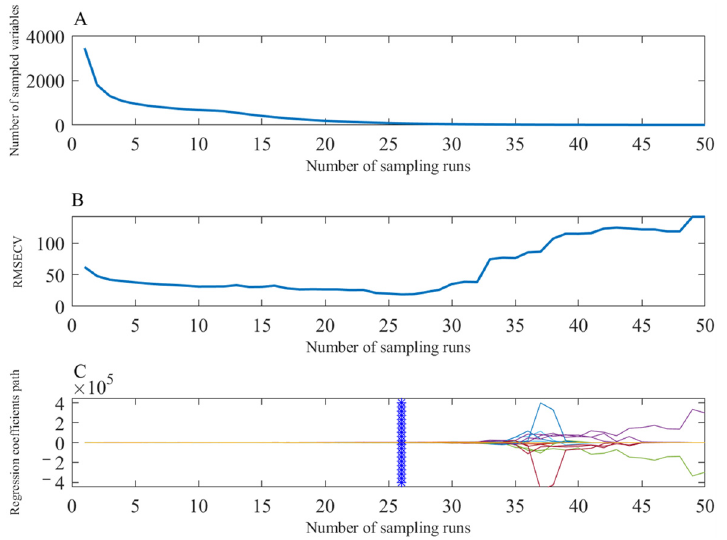
Figure 4. Results of the CARS method with the increasing of sampling runs. ( A ) the number of sampled variables; ( B ) RMSECV values; ( C ) the regression coefficients of each variables.